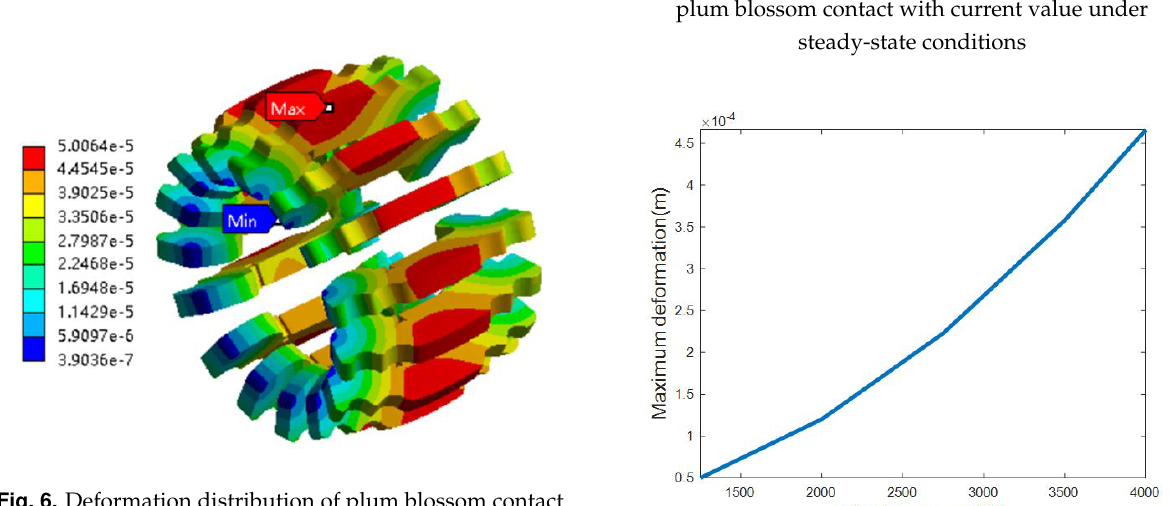
Fig. 6. Deformation distribution of plum blossom contact under steady-state current of 1250A